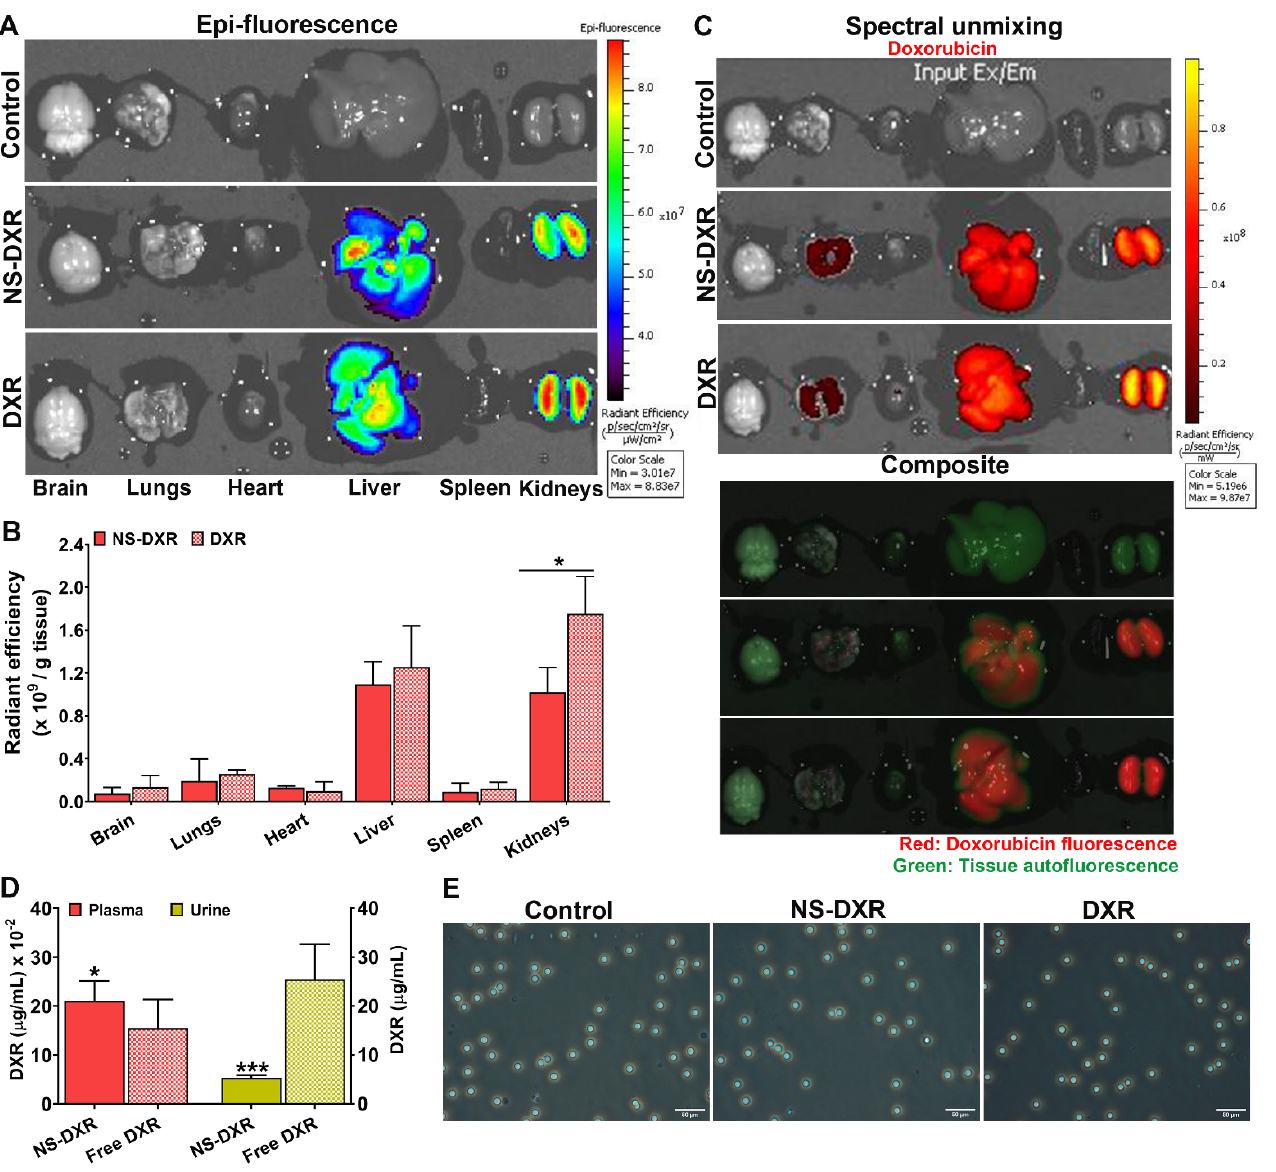
Figure 6. ( A ) Localization of NS-DXR and free DXR in organs harvested from C57BL/6 mice. The analysis was completed 1 h after the retro-orbital injection of NS-DXR (n = 4), free DXR (n = 3), or PBS (n = 2) in mice using the imaging system IVIS Caliper 200, by detection of the DXR fluorescence using the filter set λ ex / λ em : 500 nm/600 nm. ( B ) Quantification of total radiant efficiency in organs using the region-of-interest option of Living Image software; the resulting intensities were reported to the corresponding organ weight (g). ( C ) Spectral unmixing analysis to delineate the signal specific for DXR fluorescence and tissue autofluorescence. The composite image displays DXR fluorescence (red) and tissue autofluorescence (green). ( D ) Quantification of DXR in plasma and urine of mice, 1 h after administration of 3 mg/kg of free DXR or incorporated into NS-DXR, at λ ex = 480 nm and λ em = 590 nm. * p < 0.05, *** p < 0.001. ( E ) Evaluation of in vivo hemocompatibility by following the erythrocyte aggregation after the administration of NS-DXR and free DXR. Samples from mice who received PBS were considered the negative control. Scale bar: 50 µ